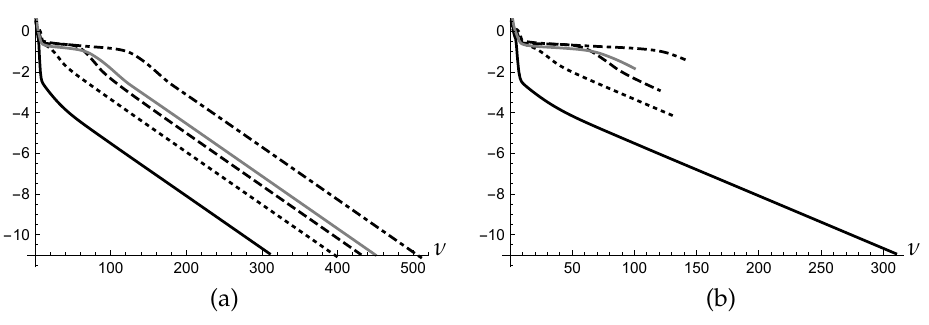
Figure 1. ( a ) History plots of MS ; ( b ) History plots of AD